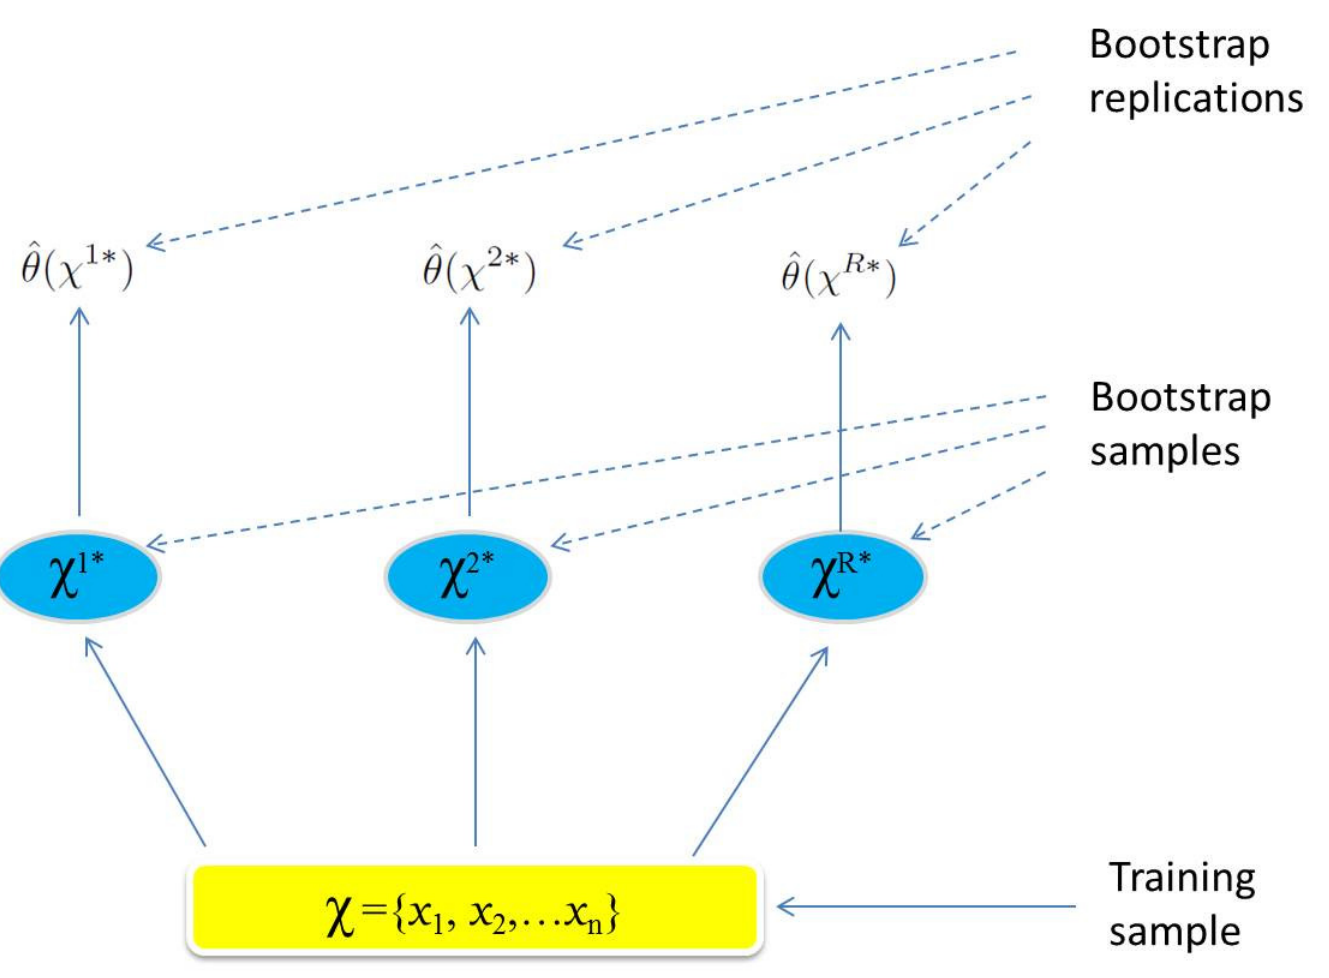
Fig 4. The Bootstrap Percentile confidence interval principle. Schematic of the bootstrap process. We want to estimate a confidence interval for the phase θ ( χ ). R training sets, χ 1 * , ... , χ R * each of size n are generated using an appropriate resampling mechanism. The quantity of interest θ ( χ ) is computed from each bootstrap training set, and the values y ð w (cid:1) 1 Þ ;:::; y ð w (cid:1) Þ are used to construct a con fi dence interval for the quantity θ ( χ ). R